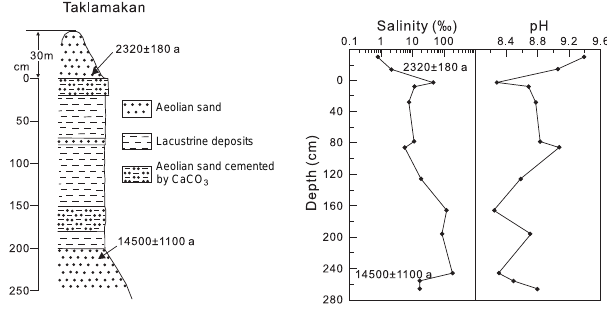
Figure 8. Sequential variations in soluble salt contents (salinity and pH) of the Yaogan-VIII section in the Taklamakan Desert.